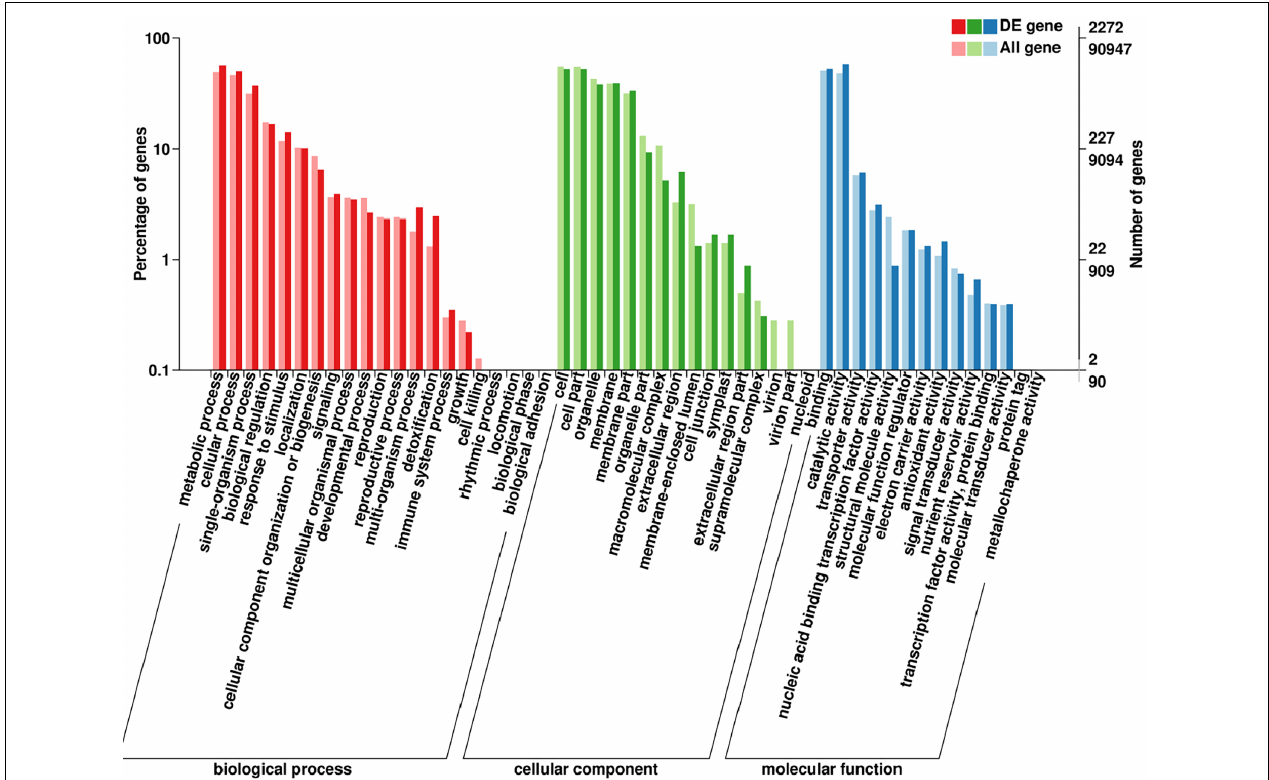
FIGURE 6 | Gene ontology (GO) analysis of the DEGs with consistent differences between the resistance and susceptible parents YD588 and YN21 and their derived resistance and susceptible bulks from their derived F 2 : 3